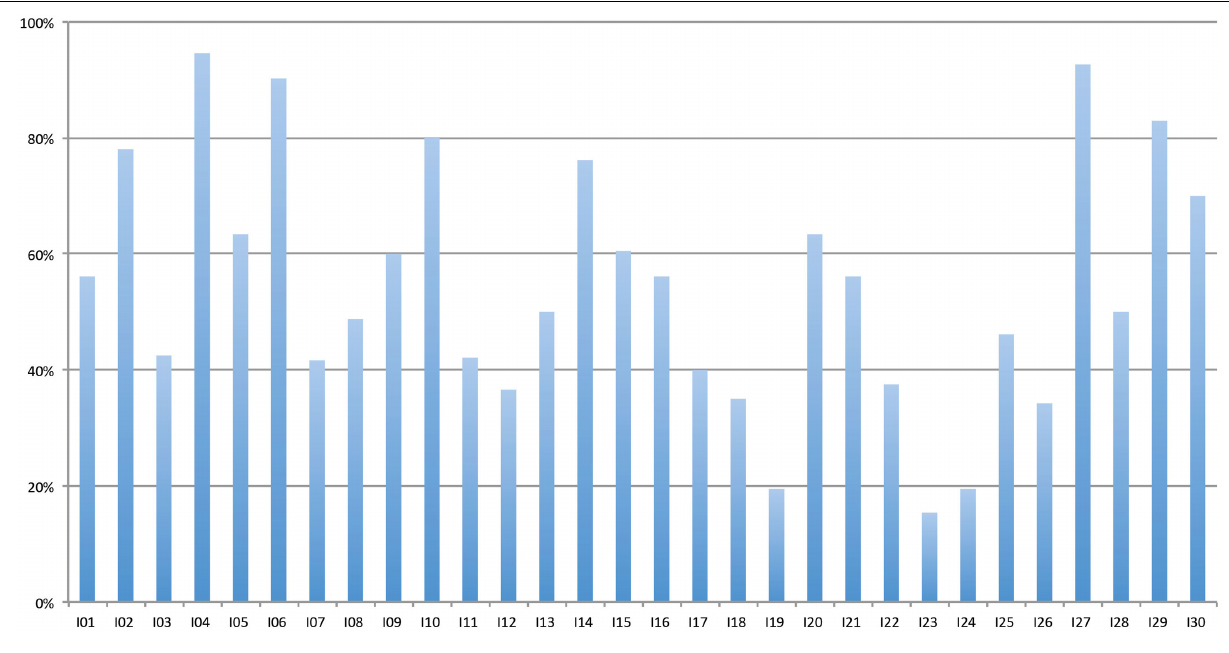
FIGURE 2 | Percent “no t” responses to the different Øt-items .